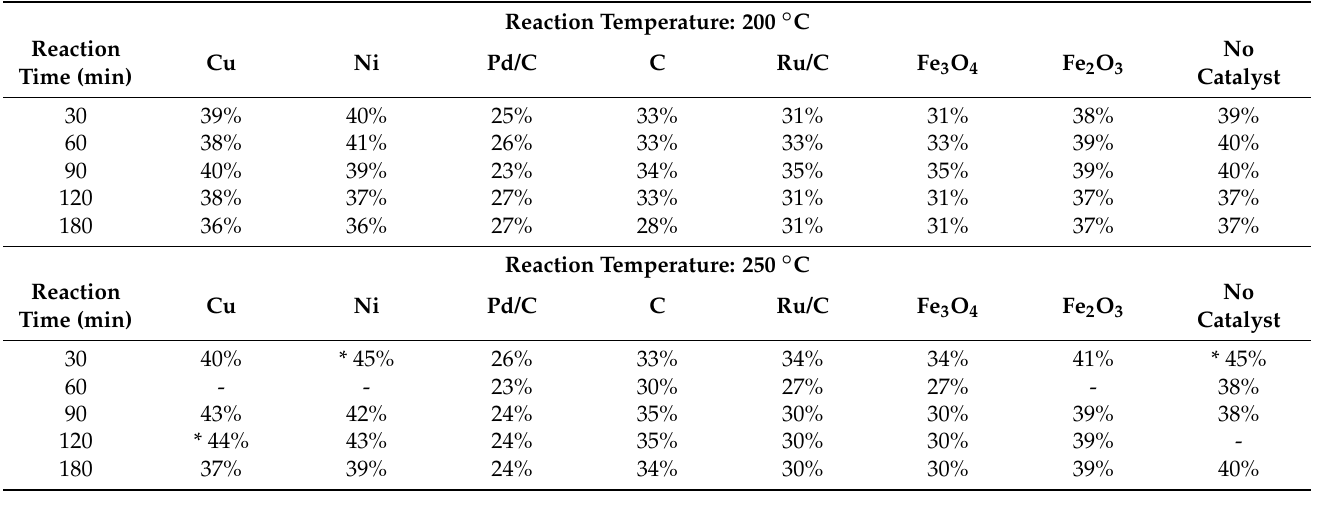
Table 2. Yields of acetic acid obtained after the hydrothermal reaction of NaHCO 3 with glucose in the presence of catalysts. The higher yields obtained after the hydrothermal reactions are marked with an asterisk